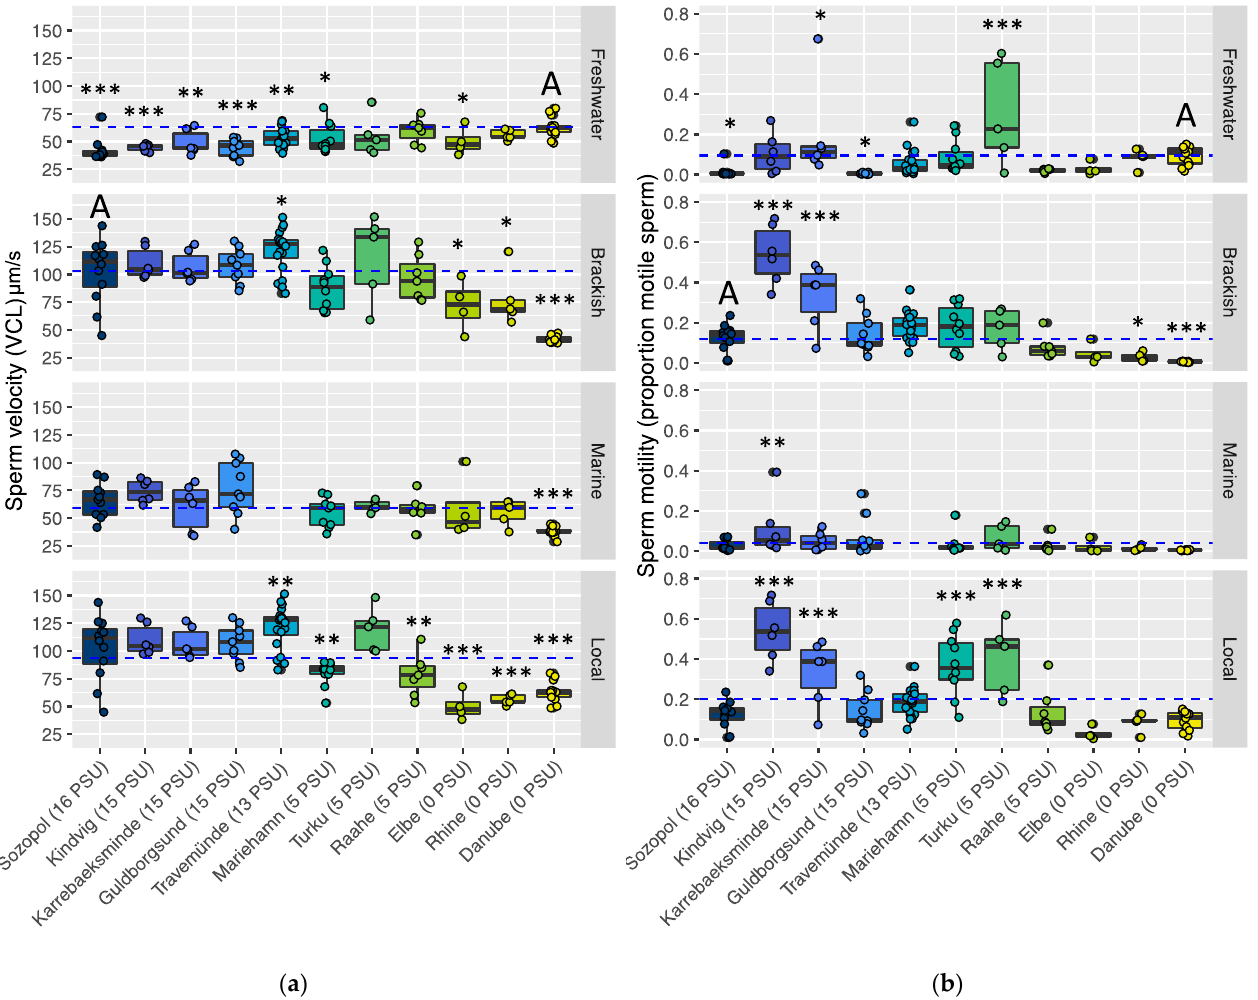
Figure 3. Sperm traits of the invasive round goby ( Neogobius melanostomus ) sampled from the ancestral range (Sozopol, far left, and the Danube, far right on x-axes) and compared against previously published data (all other sites on x-axes) [35,38,39] and across different salinities (facets). Panel ( a ) shows sperm velocity and panel ( b ) shows sperm motility. Facets show different sperm treatment salinities corresponding to freshwater (0 – 1 PSU), brackish (15 – 16 PSU), marine (30 – 32 PSU) and local with varying salinity for each site (see Table 1 for local salinity measurements and estimates). Asterisks indicate significant differences between sites and a mean value (indicated by the dashed line) using a linear model (see Supplementary Table S2 for full statistics). Means for model tests are: freshwater: the Danube (ancestral freshwater site); brackish: Sozopol (ancestral brackish site); marine: global mean across all sites; local: global mean across all sites. “A” denotes sites of ancestral origin in each respective salinity condition. * = p < 0.05, ** = p < 0.01, *** = p < 0.001.